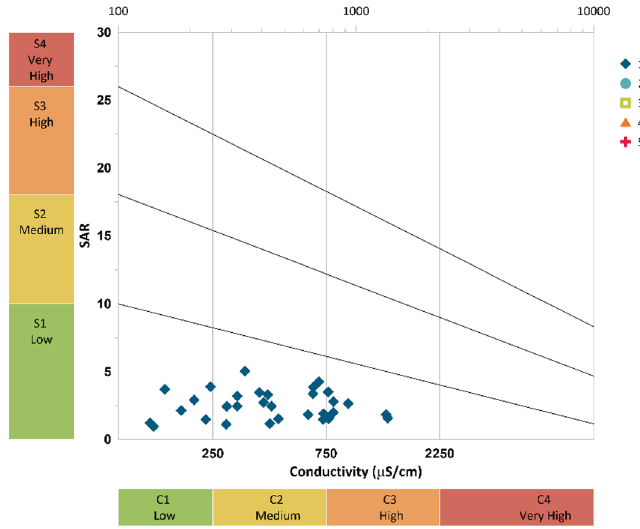
Figure 16. Classification of irrigation water using Wilcox diagram.